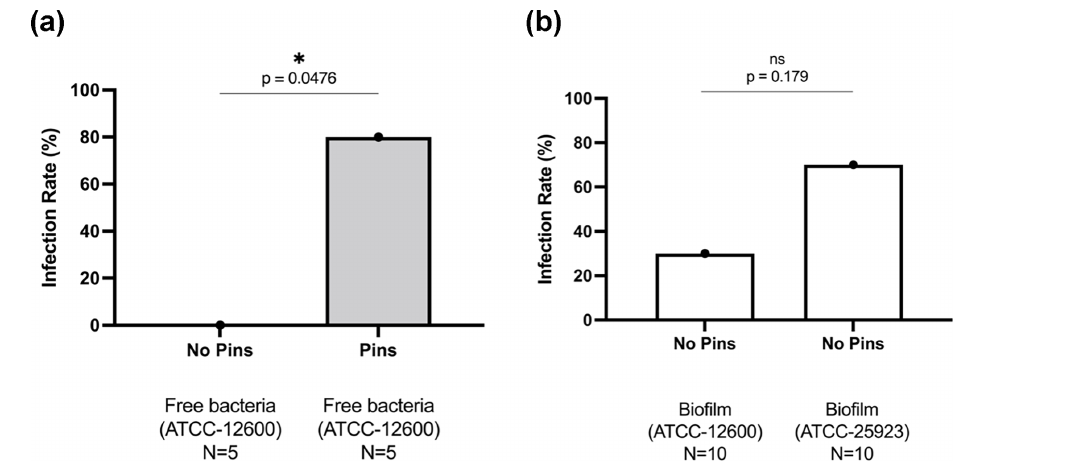
Figure 1. Study 1B. The bone infection rates (%) in mice that received TDH surgery and S. aureus inoculation: (a) comparison of inoculation with free ATCC 12600 bacteria with and without metal pins; (b) comparison of inoculation with biofilm suspensions of ATCC 12600 and ATCC 25923 without metal pins. The p values were determined by Fisher’s exact test from individual experiments.